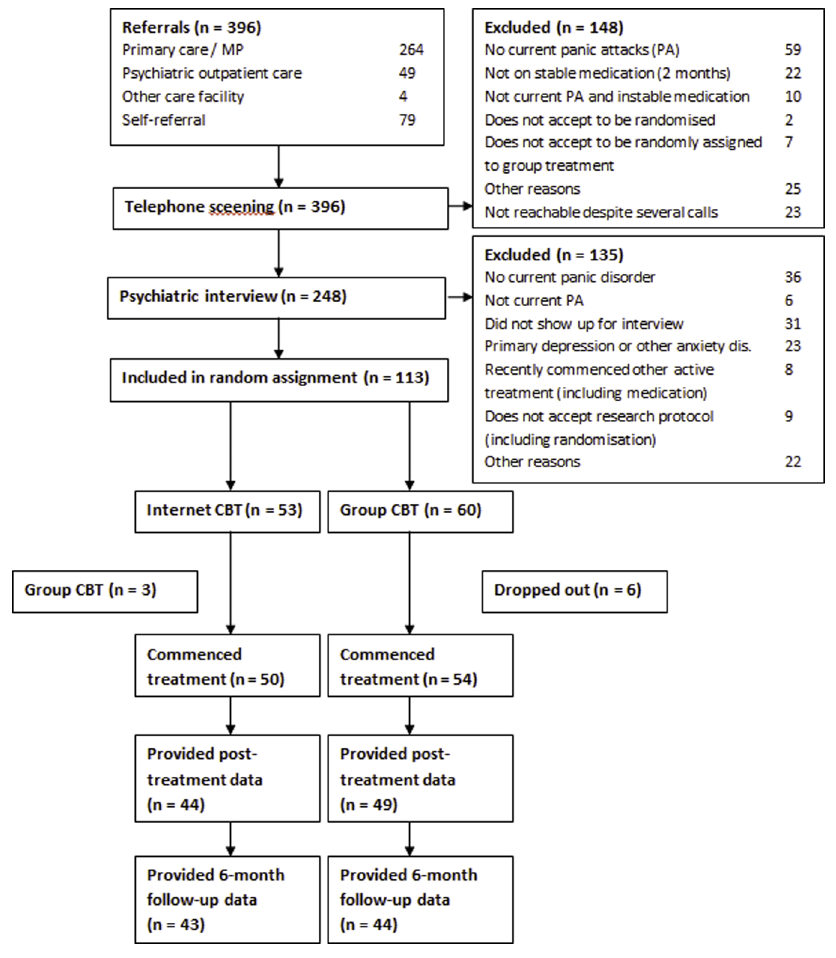
Figure 1. Flowchart of study participants, point of random assignment, and dropouts.